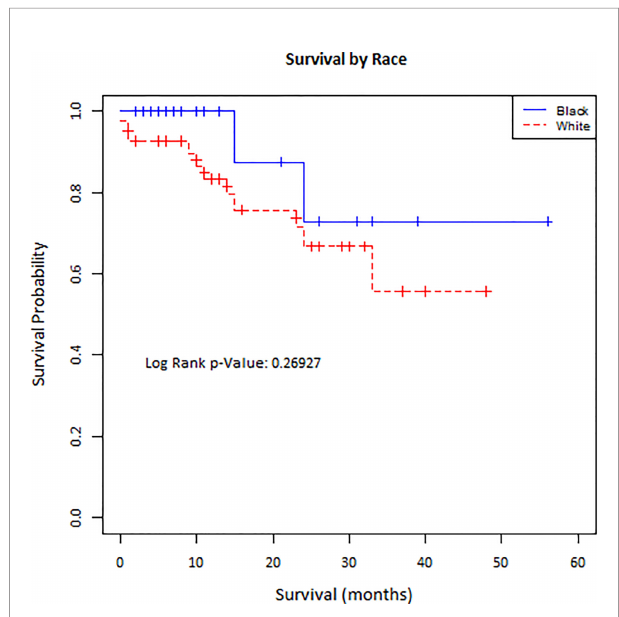
FIGURE 1 | Kaplan-Meier curve of survival for Black and White patients undergoing CRS and